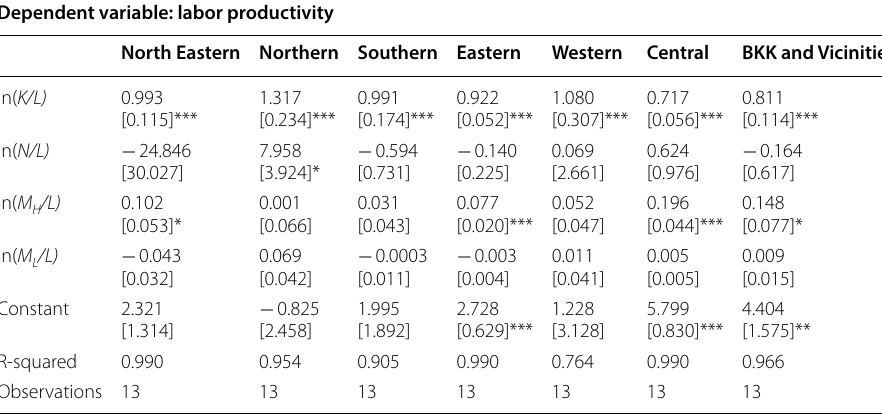
Standard errors are in parentheses *, **, *** indicate significant at 10%, 5%, and 1% level of significance, respectively